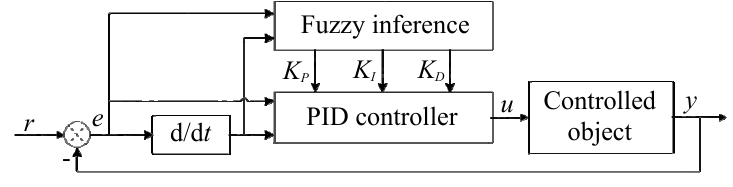
Figure 5. ( a–c ). fuzzy controller with different dimensions.